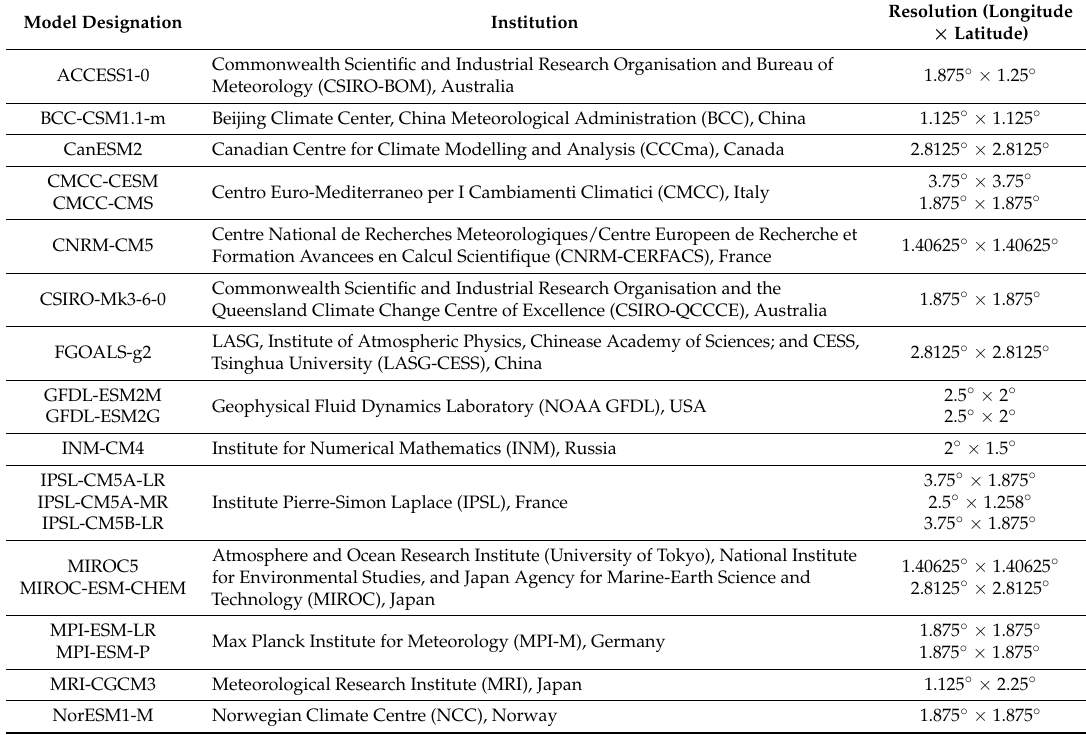
Table 1. Description of CMIP5 models used in the present